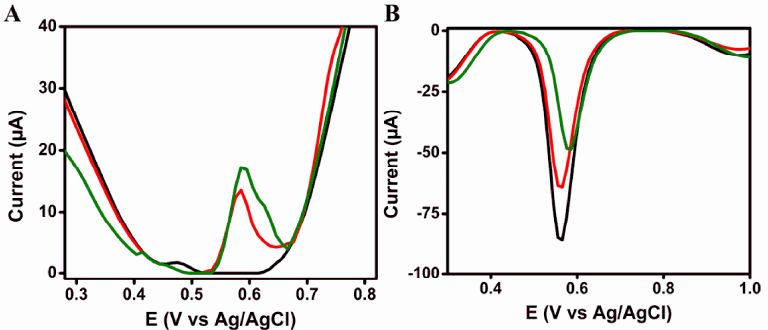
Figure 8. Real sample analysis: ( A ) in oxidation and ( B ) in reduction of blank diluted serum (black) and diluted serum spiked with 10 µM (red) and 50 µM (green) final concentrations of VAN.